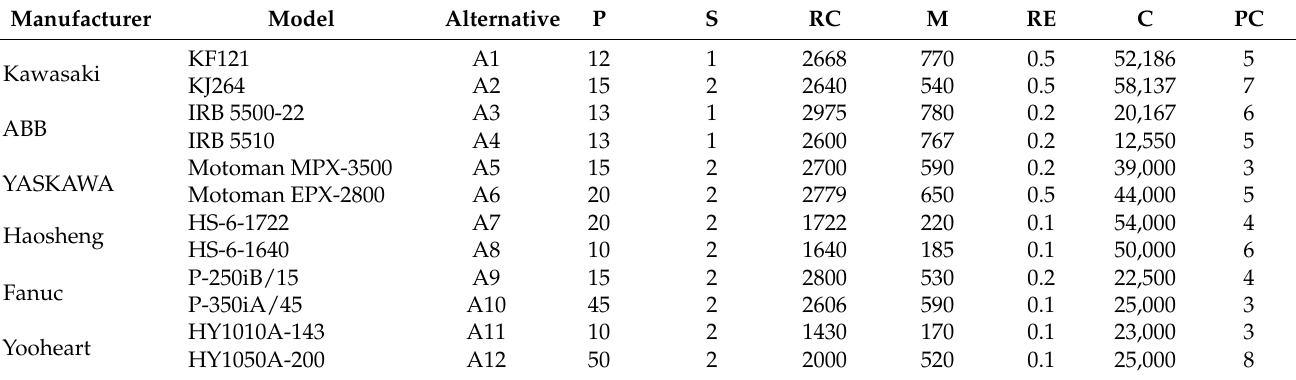
Table 1. Decision matrix consisting of various robot models and their features [22].